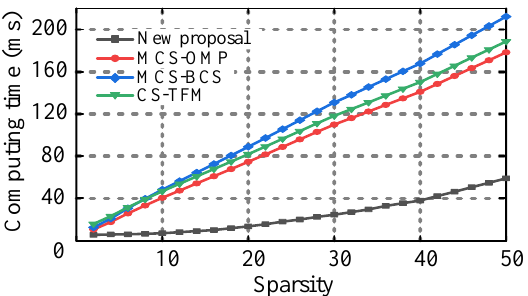
Figure 3. Comparison of calculation time of different algorithms for Class D test signals.